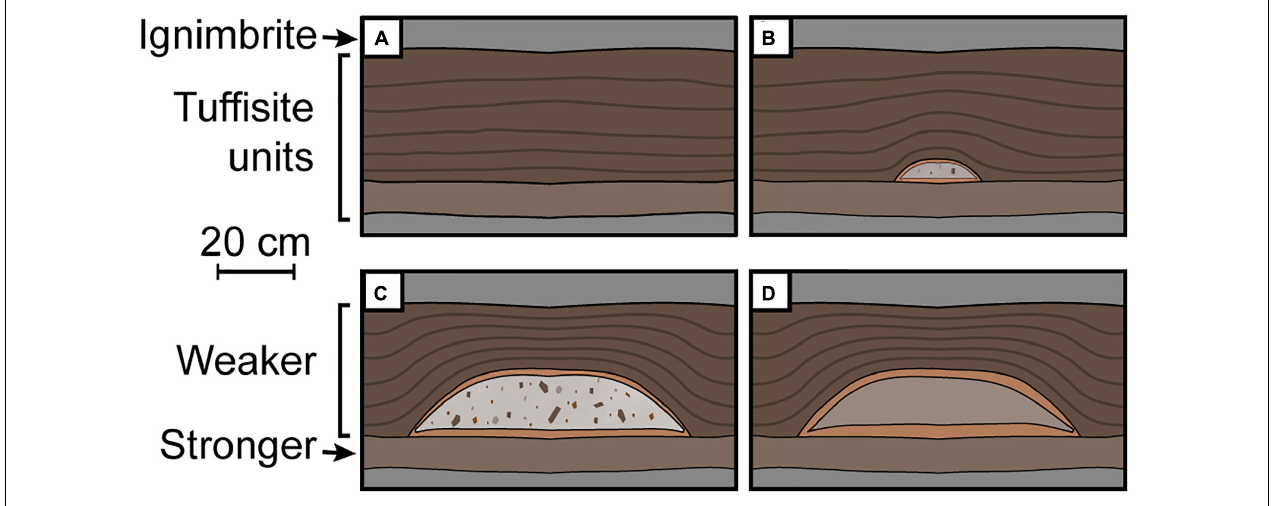
FIGURE 11 | Schematic showing the formation of fine rimmed subhorizontal lenses (Structure 5) as finger-shaped injections. (A) Fluid flowing perpendicular to the plane of the outcrop opens a pathway between a stronger and weaker unit. (B) The widening of the fluid pathway is accommodated by deformation of the weaker material above, forming an intrusion with a domed top and flat base. (C,D) Material is deposited inside the intrusion, with fine material deposited first, forming the margins, and coarser material deposited at the